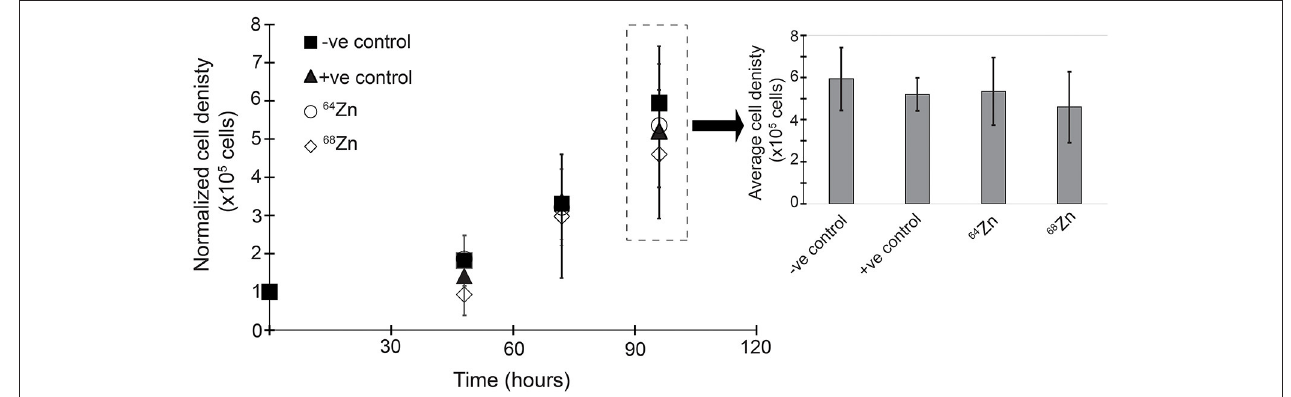
FIGURE 3 | Zinc isotope enrichment proliferation after 96h under different medium Zn conditions: -ve control = negative control without Zn; + ve control = positive control with 20 µ M “natural” Zn; 64-Zinc = 20 µ M 64 Zn and 68-Zinc = 20 µ M 68 Zn only.